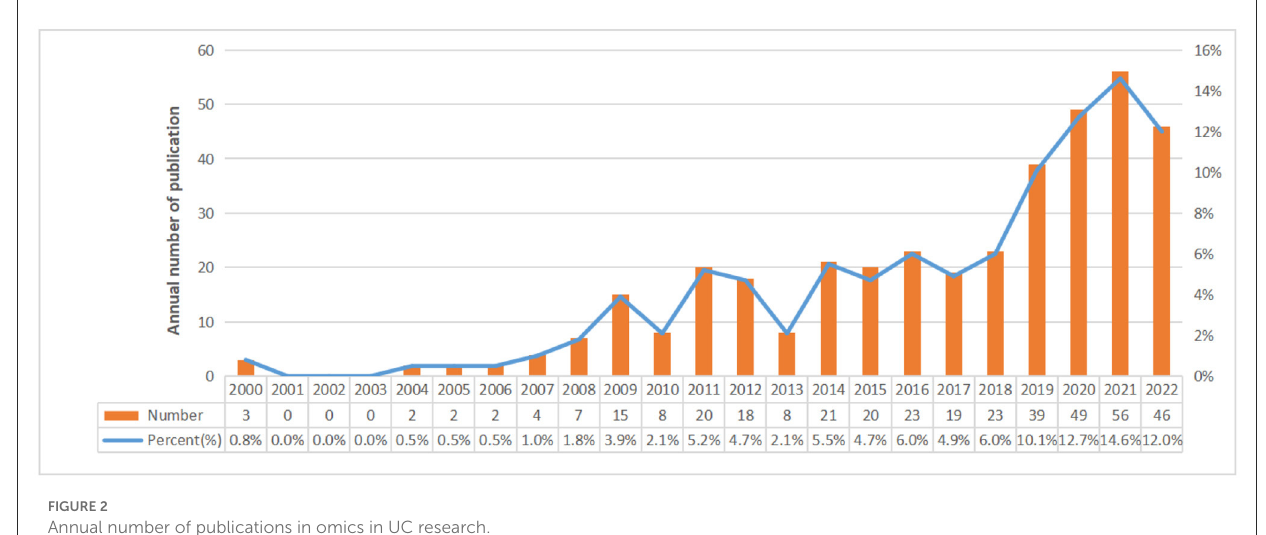
FIGURE2 Annual number of publications in omics in UC research.